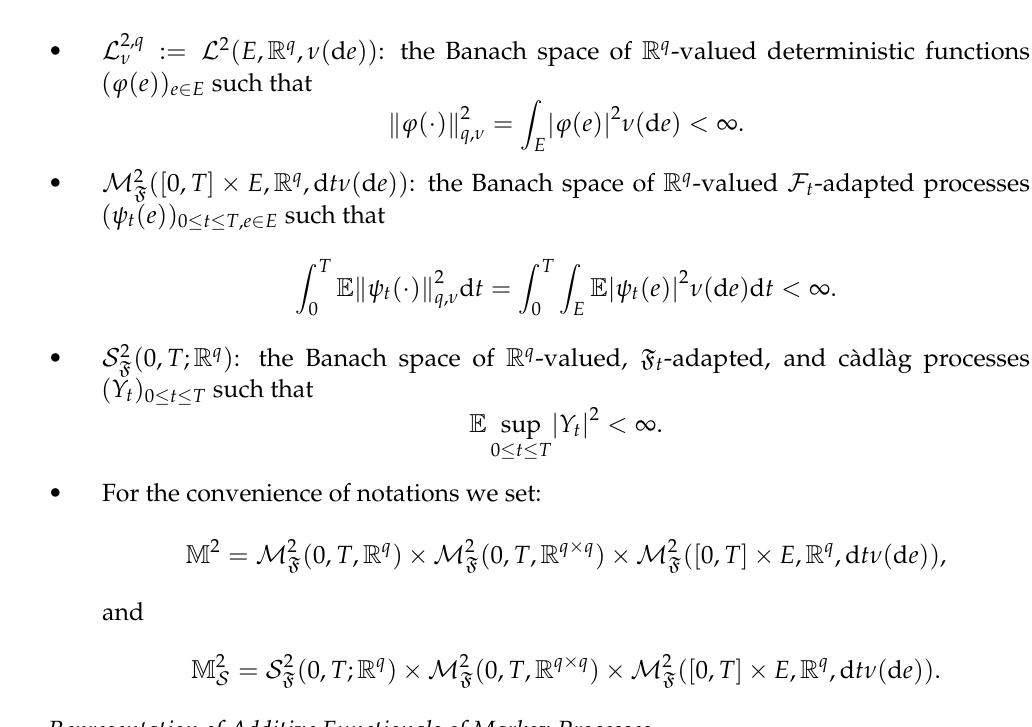
Representation of Additive Functionals of Markov